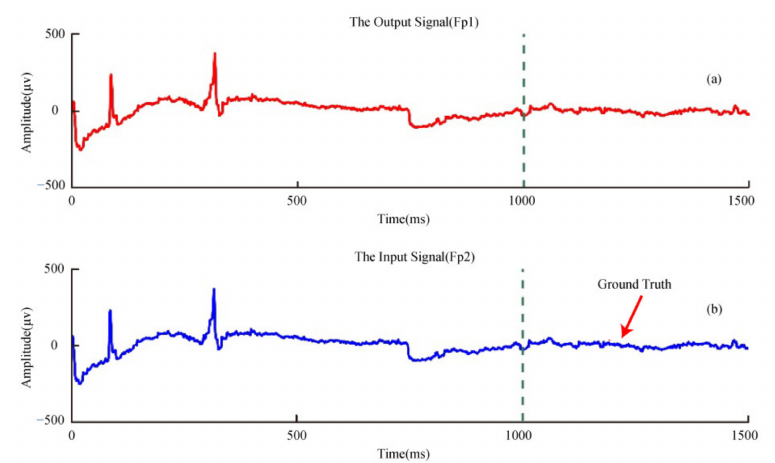
Figure 3. The input and output waveforms. ( a ) The system input. ( b ) The system output. The time series on the left side of the green dotted line is used for parameter estimation, and the data on the right side indicate the fitting results of both ARX models.